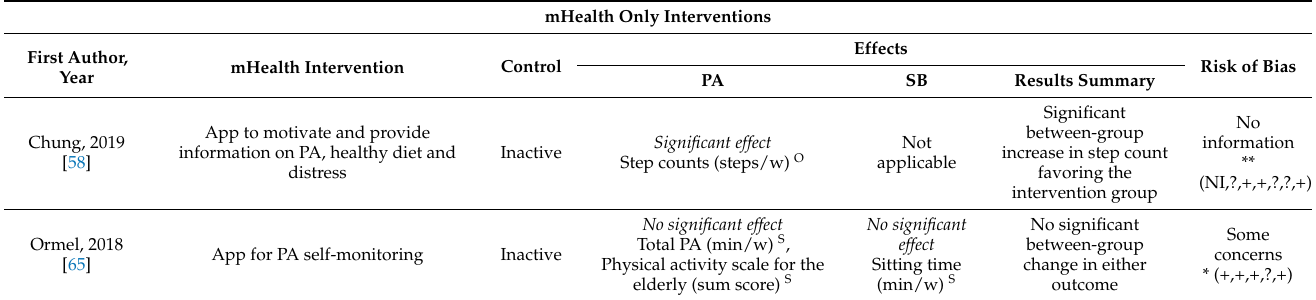
Table 2. Physical activity (PA) and sedentary behavior (SB) intervention effects were reported in controlled